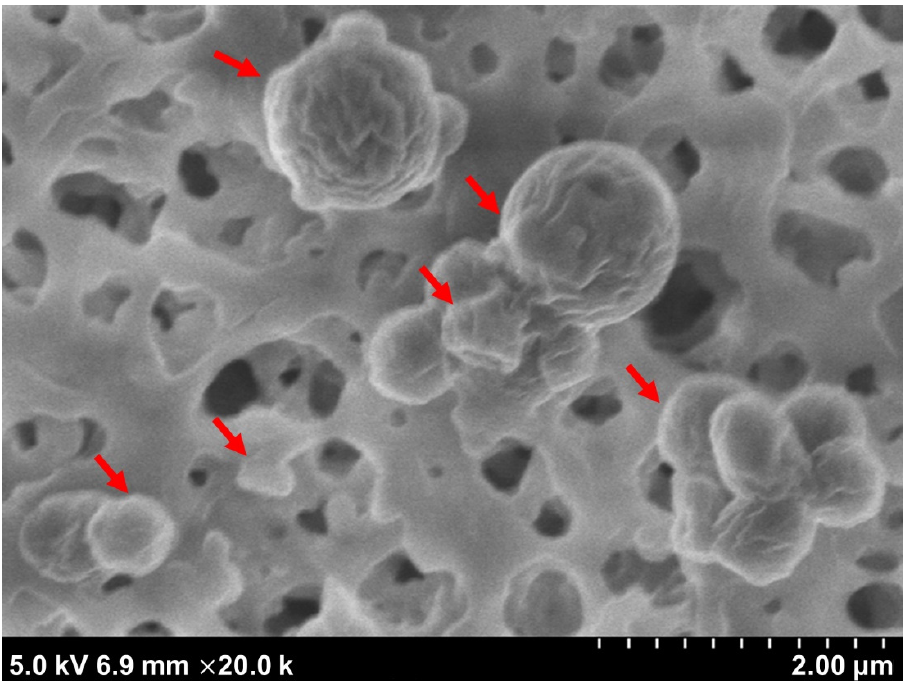
Figure 3. SEM micrograph of BLG nanoparticles within the first peak attached to the surface of a 0.22 μ m cellulose acetate membrane. The image shows spherical NPs (indicated with arrows). Magnification × 20,000.